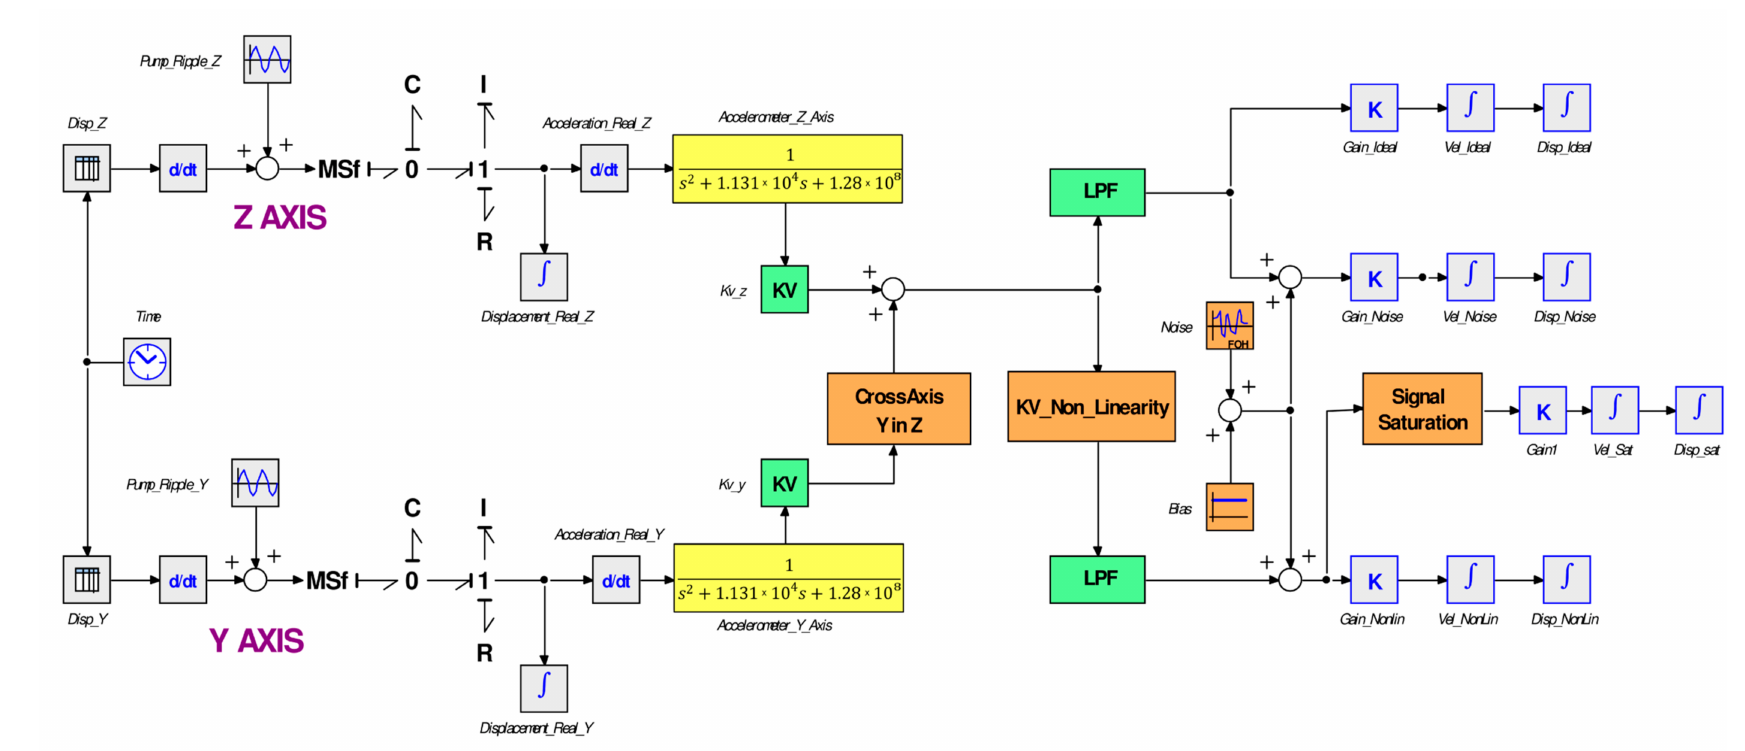
Figure 3. Bond graph model for Z axis displacement. modular flow